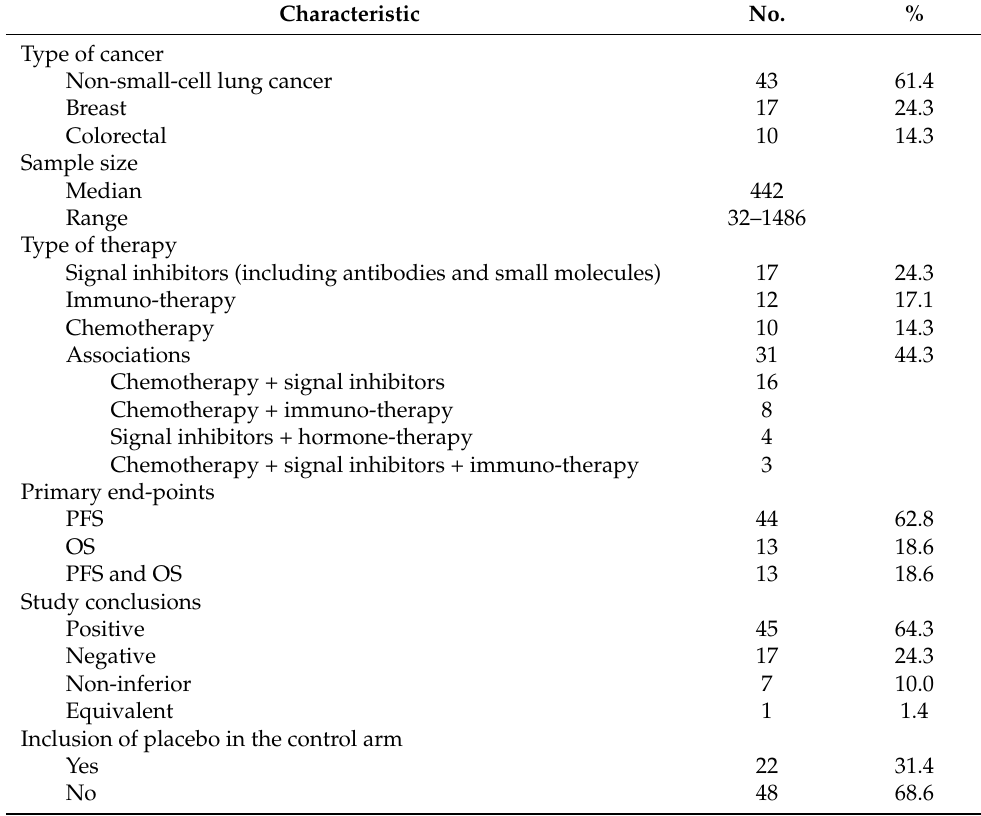
Table 1. Characteristics of the selected phase III clinical trials (a total of 70 studies were analysed).